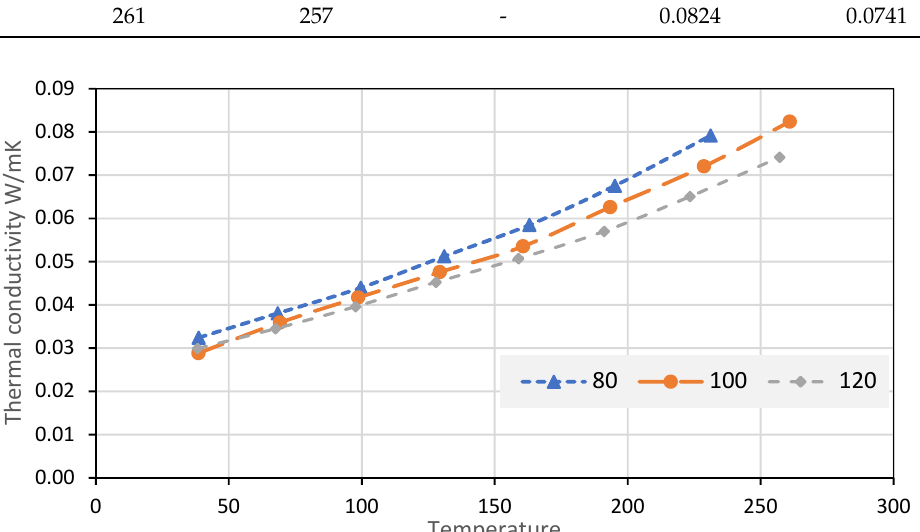
Figure 6. Dependence of the thermal conductivity coefficient (W/m°C) from the temperature (°C) for three samples with a density of 80 kg/m 3 .